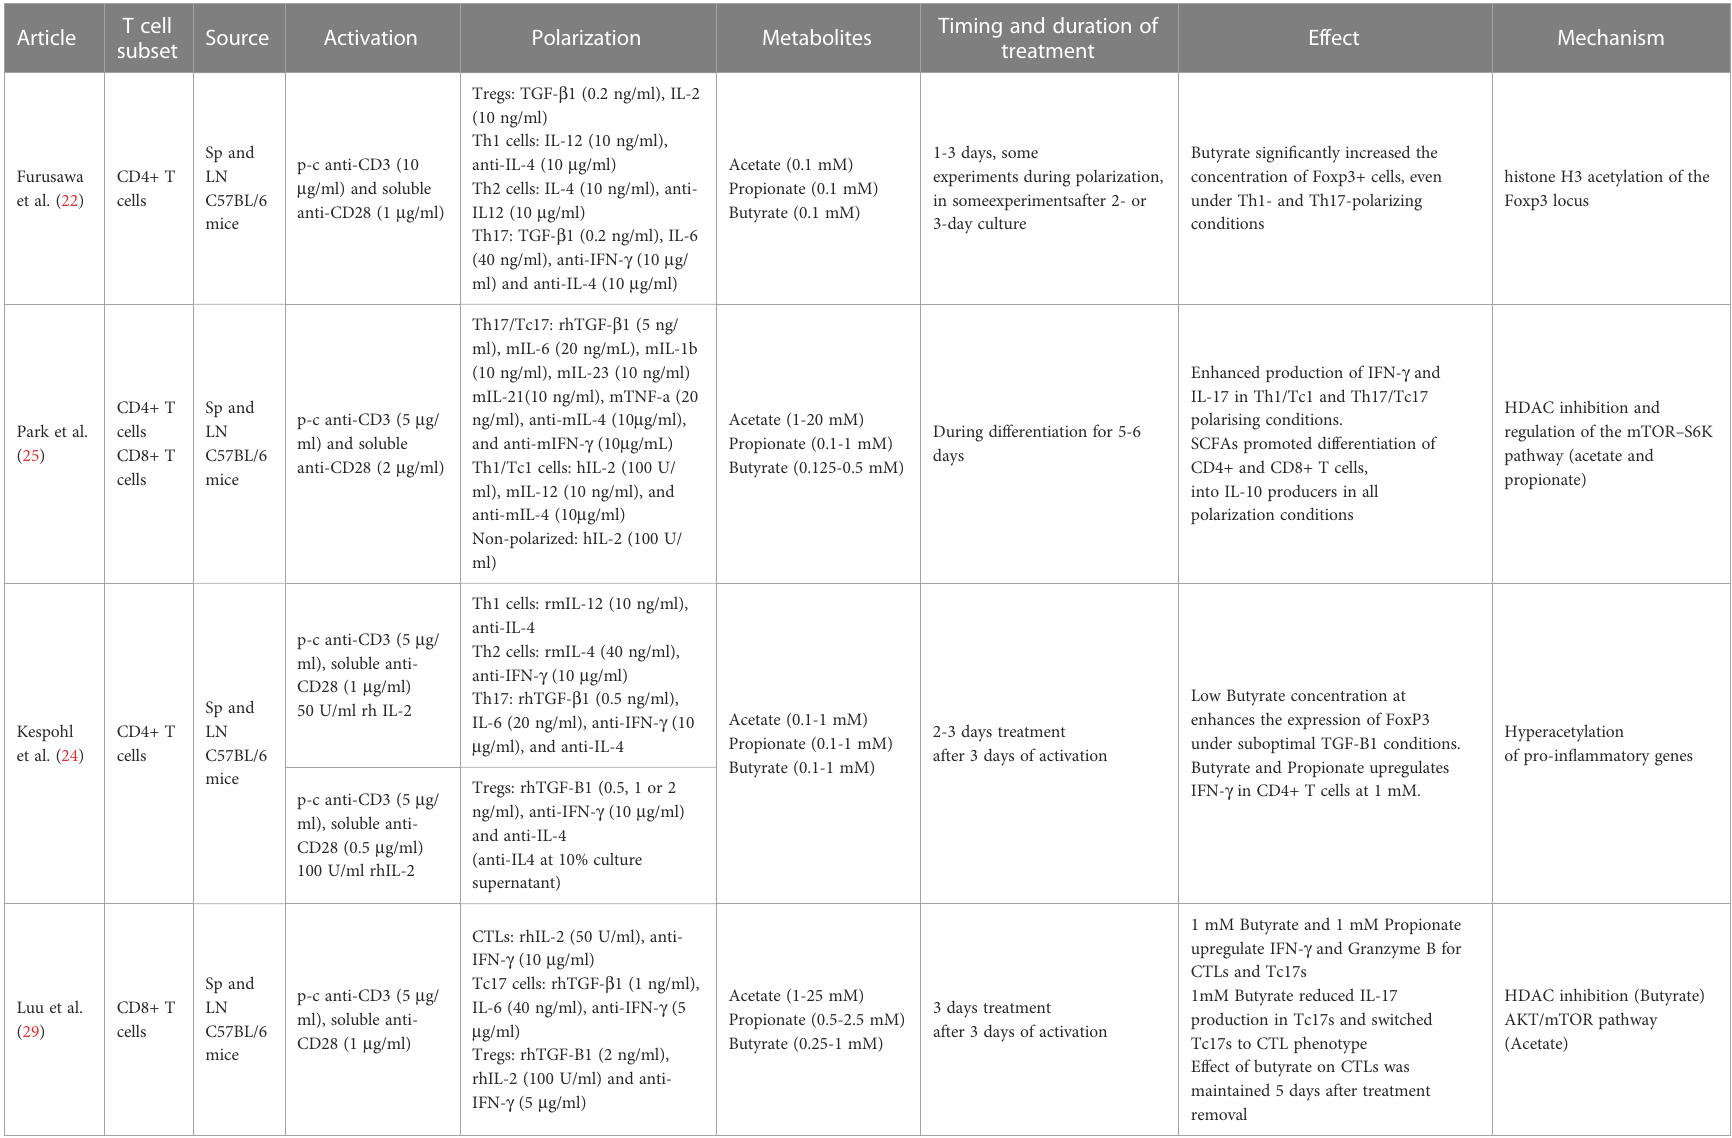
TABLE 2 Summary of methods and results from ex vivo SCFA effects on murine T cell